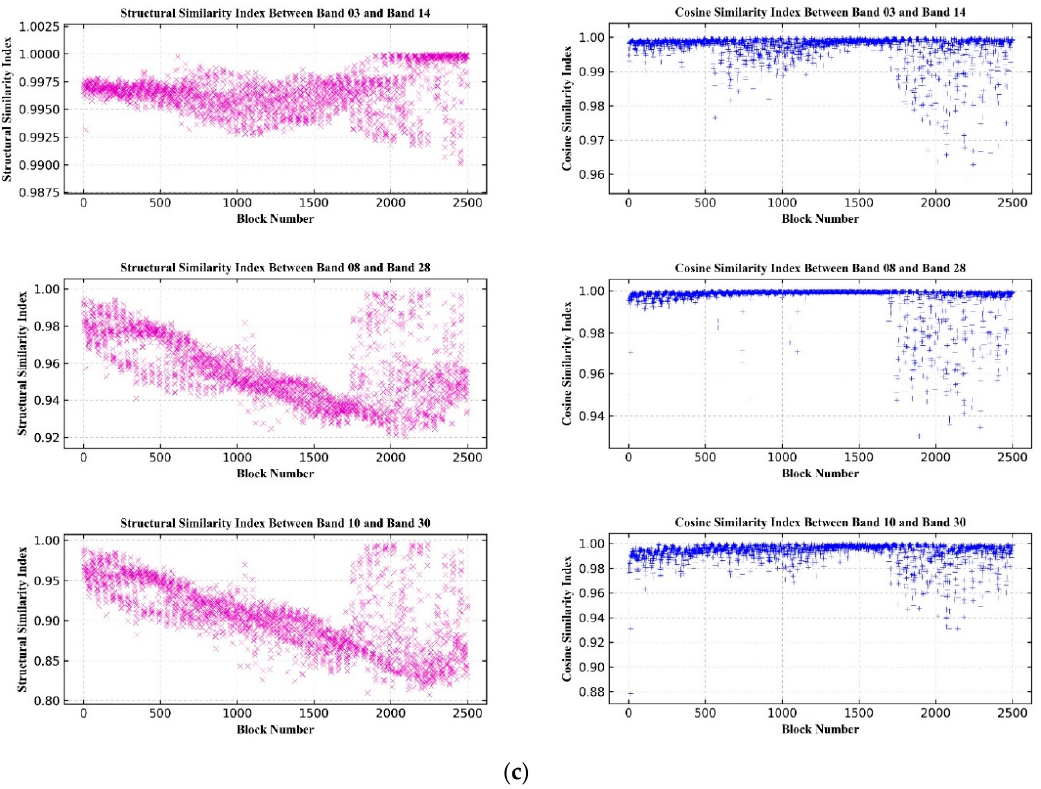
Figure 13. Similarity measures for the registered spectral bands. ( a ) OHS–Arizona, USA; ( b ) OHS–Guangxi, China; ( c ) OHS–Xinjiang, China.